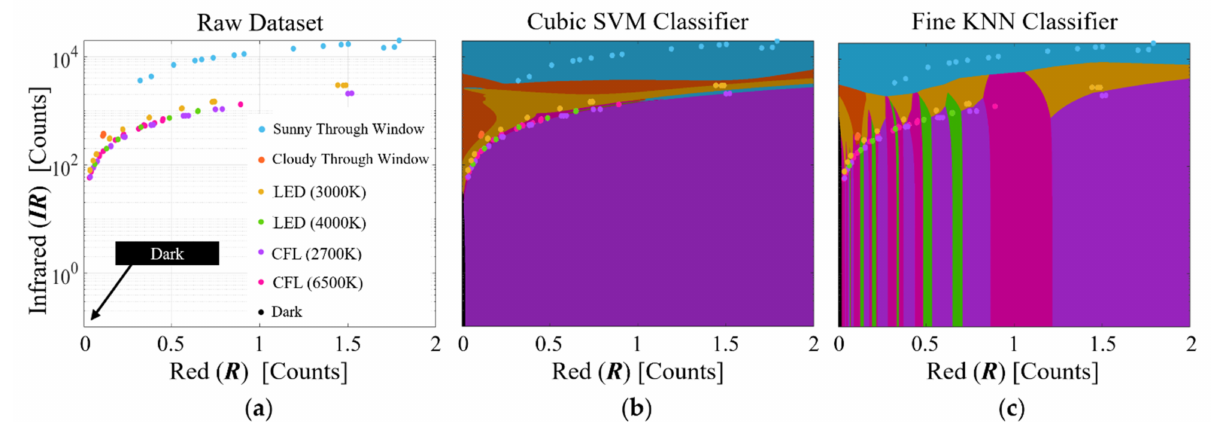
Figure 5. Representation of the 126 observations in the raw dataset. ( a ) Each observation is positioned according to the R and IR values. Decision surface of ( b ) the Cubic SVM classification method and ( c ) the Fine KNN classification method, both using I data configuration. Decision surfaces of the four best classifiers are shown in the Supplementary Figure